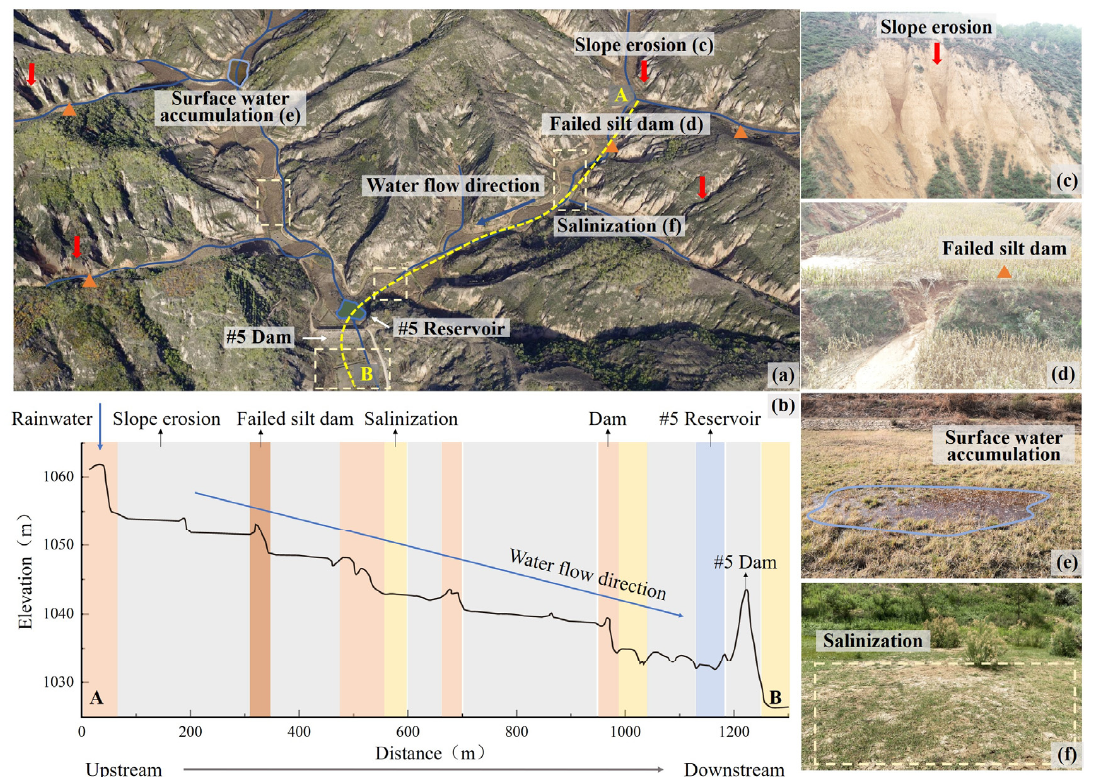
Figure 15. Disaster chain in the GTW and some field photos. ( a ) Spatial distribution of regional disasters; ( b ) spatial distribution of geohazards along the A–B profile; ( c ) site photo of slope erosion; ( d ) site photo of the failed silt dam; ( e ) surface water accumulation on the surface of arable land; ( f ) site photo of saline particles precipitating on the surface of arable land.